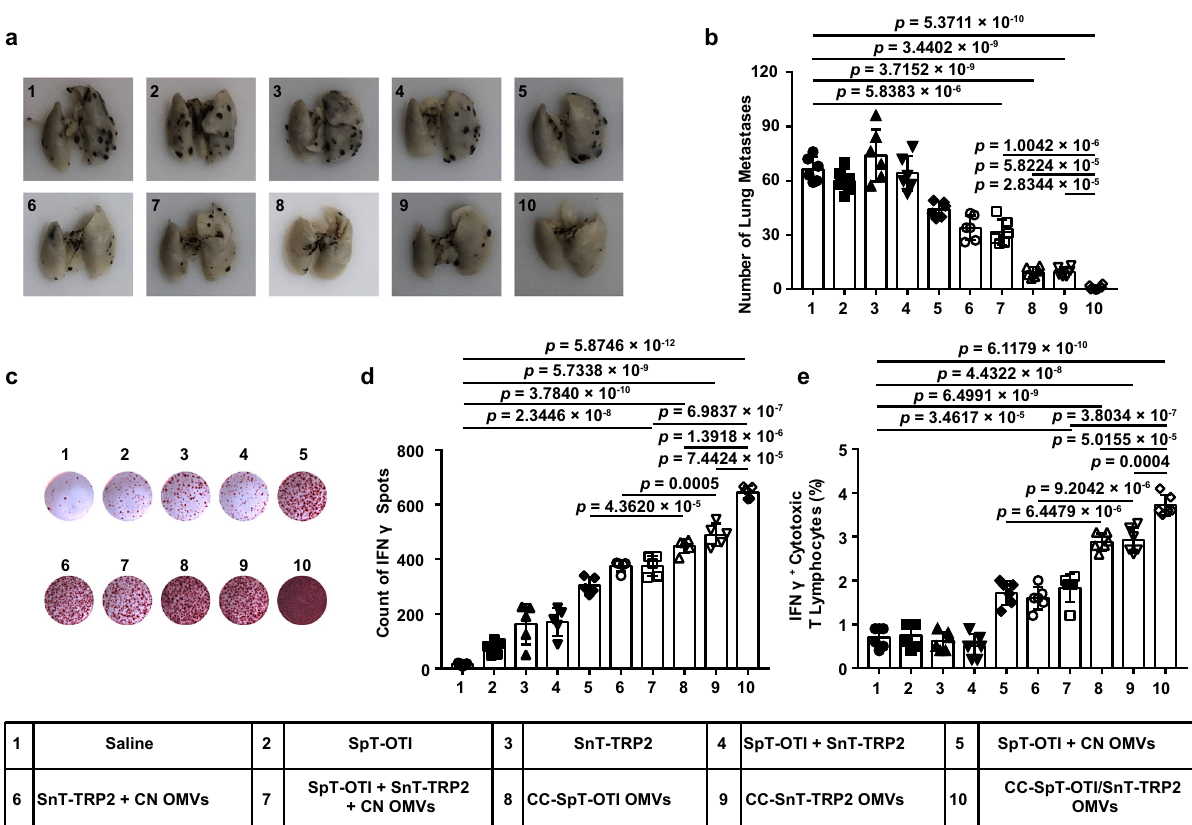
Fig. 6 Dual-tumor antigen (OVA 257 – 264 and TRP2 180 – 188 ) display by catcher-decorated OMVs stimulates CD8 + T-cell-mediated, synergistic immune therapeutic effects. SpT-OTI and SnT-TRP2 were displayed either singly (CC-SpT-OTI OMVs or CC-SnT-TRP2 OMVs) or simultaneously (CC-SpT-OTI/ SnT-TRP2 OMVs) by CC OMVs. Mixed formulations (SpT-OTI + CN OMVs, SnT-TRP2 + CN OMVs, and SpT-OTI + SnT-TRP2 + CN OMVs) were